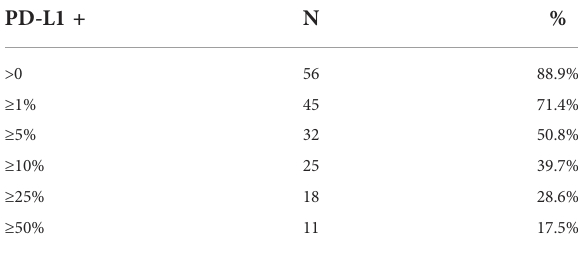
TABLE 2 Number and proportion of patient samples with tumor PD- L1 expression as determined by commonly used cut points,